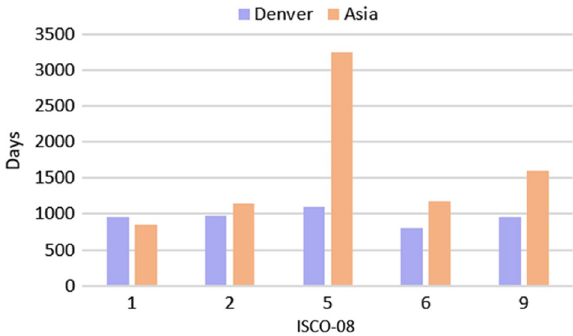
Fig. 4 Time to reach management for users in our dataset